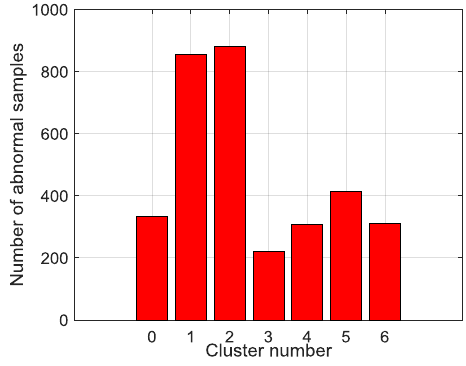
Figure 7. Distribution of anomaly data.